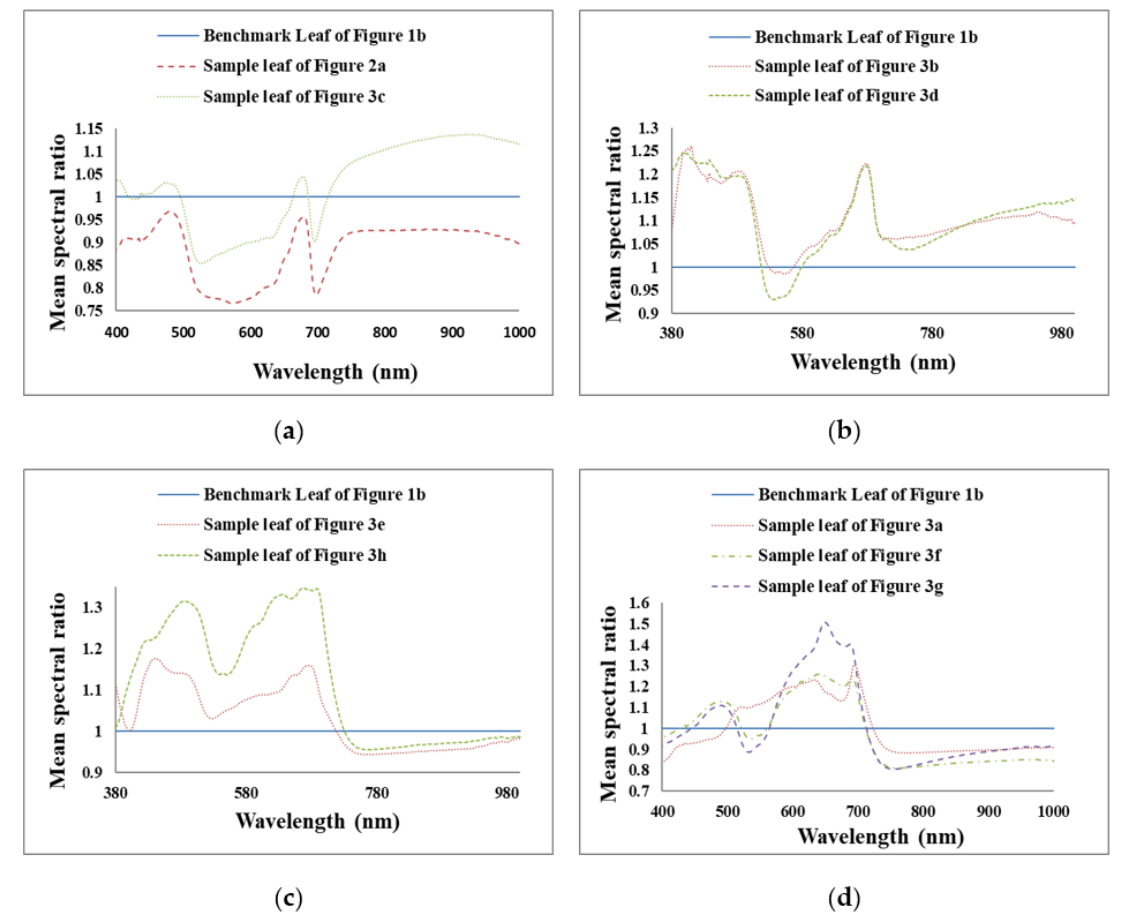
Figure 6. Mean spectral ratios of different unhealthy leaves (whole area) to benchmark leaf to compare the change in the curve shape of unhealthy leaves with respect to a healthy benchmark leaf. ( a ) Unhealthy leaves with many small white and few brown spots and unhealthy leaves with few brown spots exhibit almost similar ratio curve trends from 380 nm to 1000 nm ( b ) unhealthy leaves with several large brown spots and unhealthy leaves with brownish regions have almost similar ratio curves between the wavelength range 491 nm and 825 nm. ( c ) the similar shaped ratio curves of unhealthy leaf with brown spots and holes with an unhealthy leaf with brownish regions and holes in the ~ 400 nm and 1000 nm wavelength range. ( d ) The unhealthy leaf with brown and yellowish regions and unhealthy leaf with many large brown regions have similar ratio curves with higher ratio values for the latter between ~ 570 nm to 1000